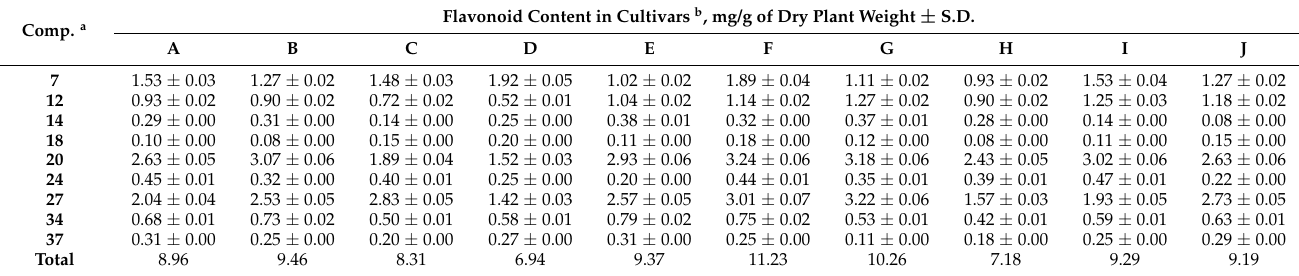
Table 7. Content of nine flavonoids in flowers of ten cucumber cultivars. Comp.